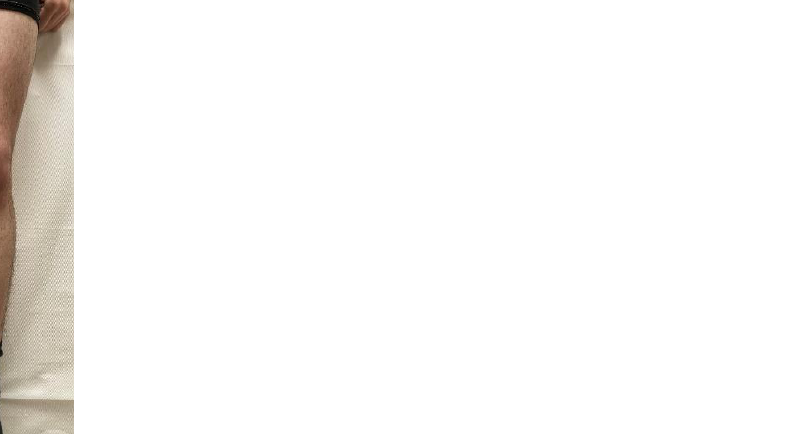
Figure 8. Proportional regeneration of the right femoral anterior muscle mass at 6 months post-op.